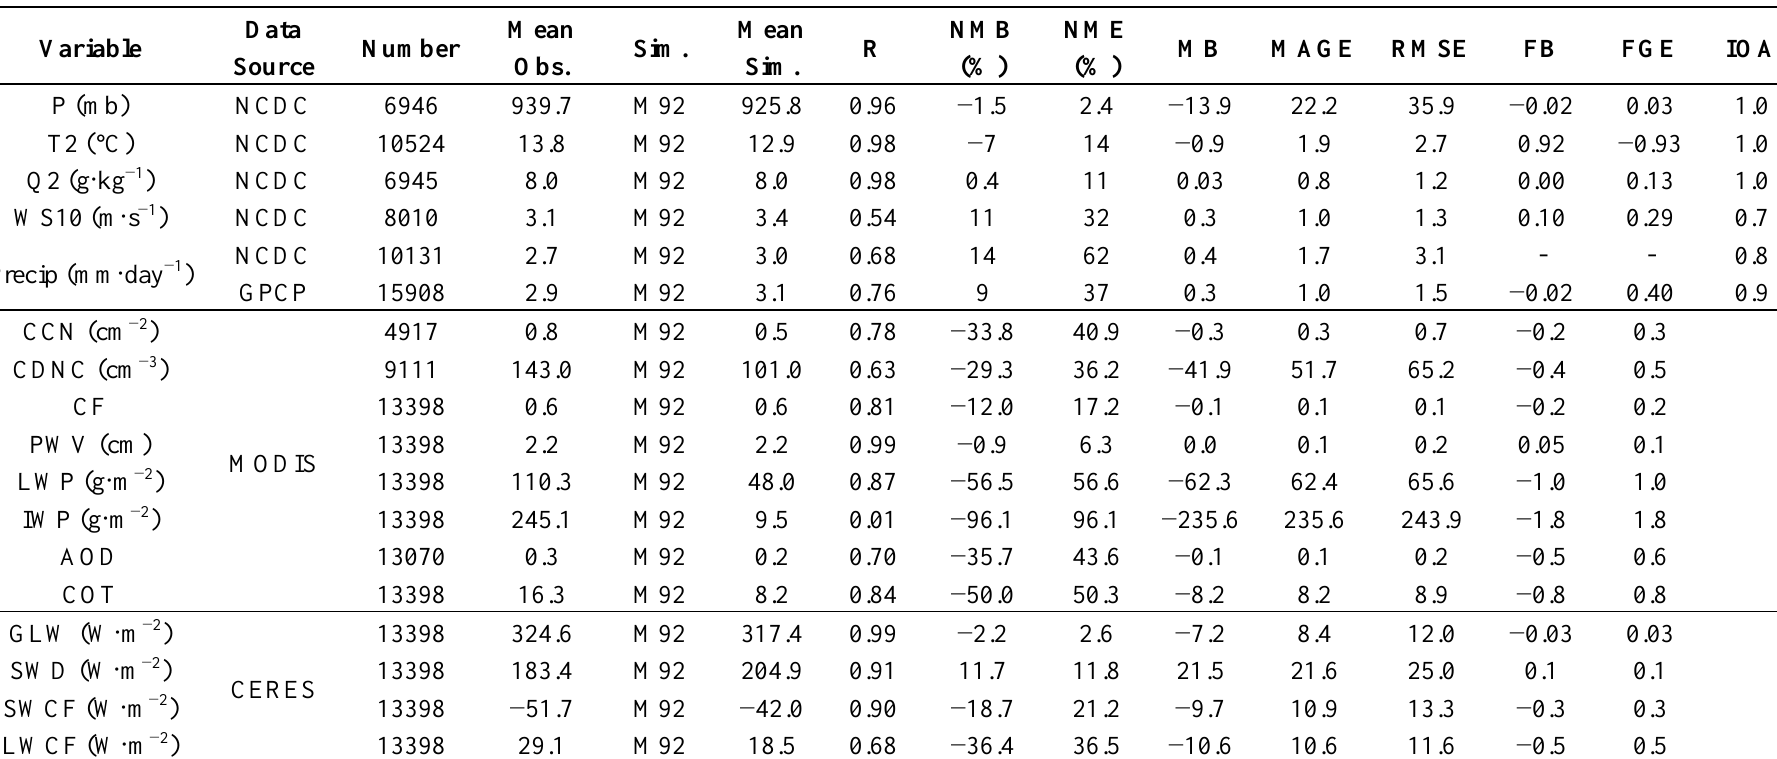
Table 3. Performance statistics for meteorological predictions for 2006 WRF-CAM5 baseline simulation with